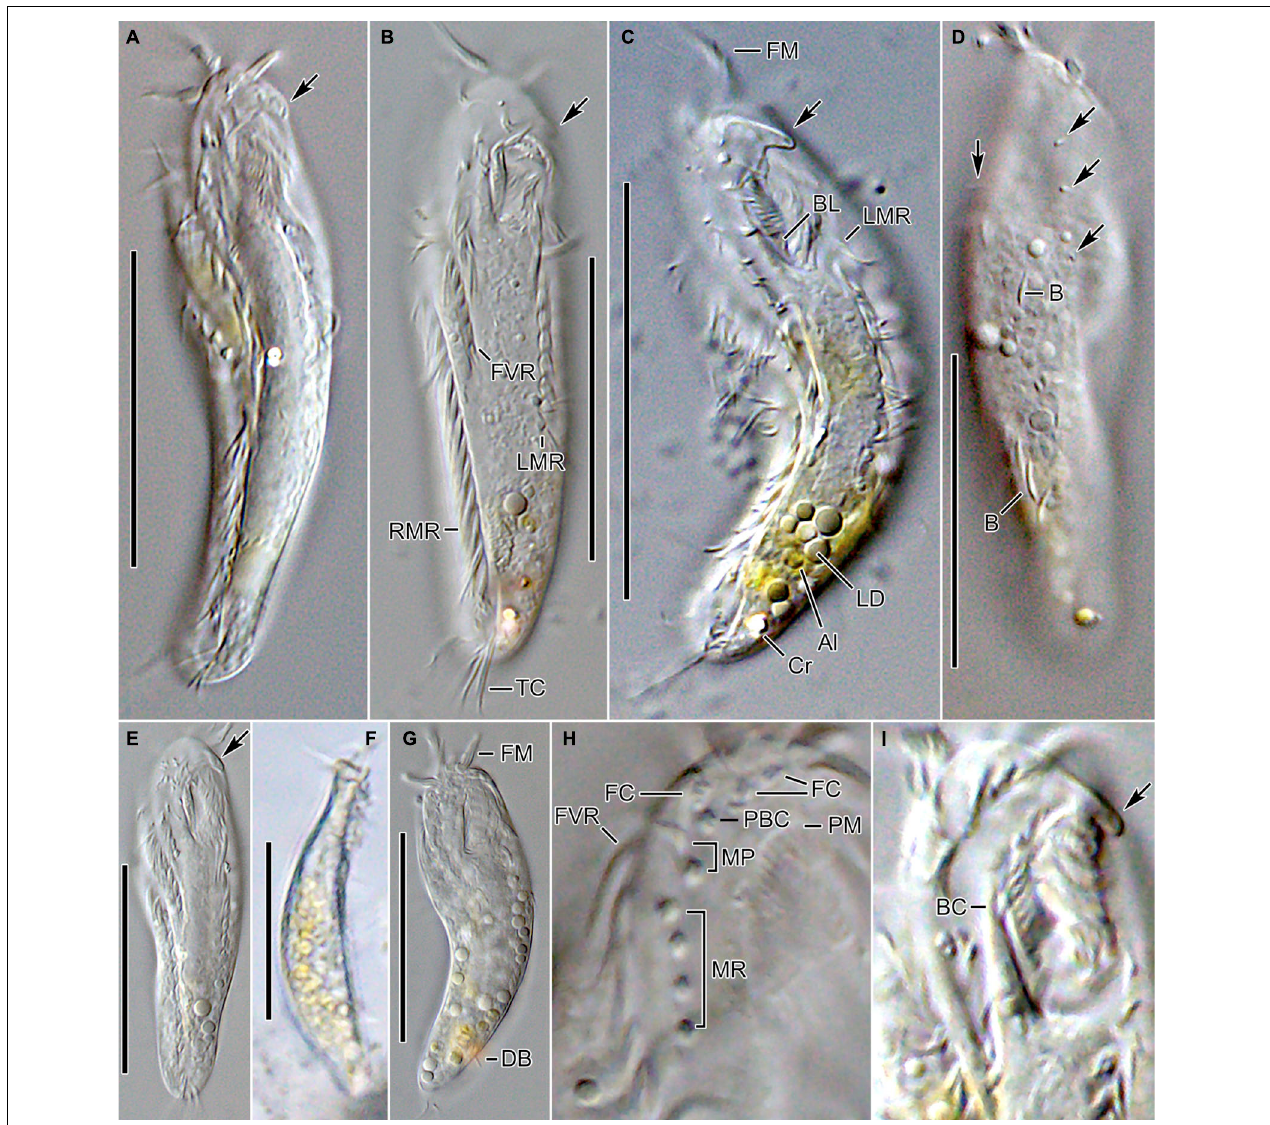
FIGURE 2 | Tunicothrix halophila n. sp. in vivo . (A–C,E) Ventral views showing morphology. Arrows denote beak-like protrusion. (D) Dorsal view showing dorsal bristles (arrows) and arc-shaped cortical structures. (F) Lateral view. (G) Ordinary size of dorsal bristles. (H) Cirri on right frontoventral area. (I) Oral apparatus with beak-like protrusion (arrow). Al, algae; B, arc-shaped structures; BC, buccal cirrus; BL, left wall of buccal lip; Cr, cytoplasmic crystals; DB, dorsal bristles; FC, frontal cirri; FM, frontal adoral membranelles; FVR, frontoventral row; LD, lipid droplets; LMR, left marginal row; MP, midventral pair; MR, midventral row; PBC, parabuccal cirrus; PM, paroral membrane; RMR, right marginal row; TC, transverse cirri. Scale bars 30 µ m.